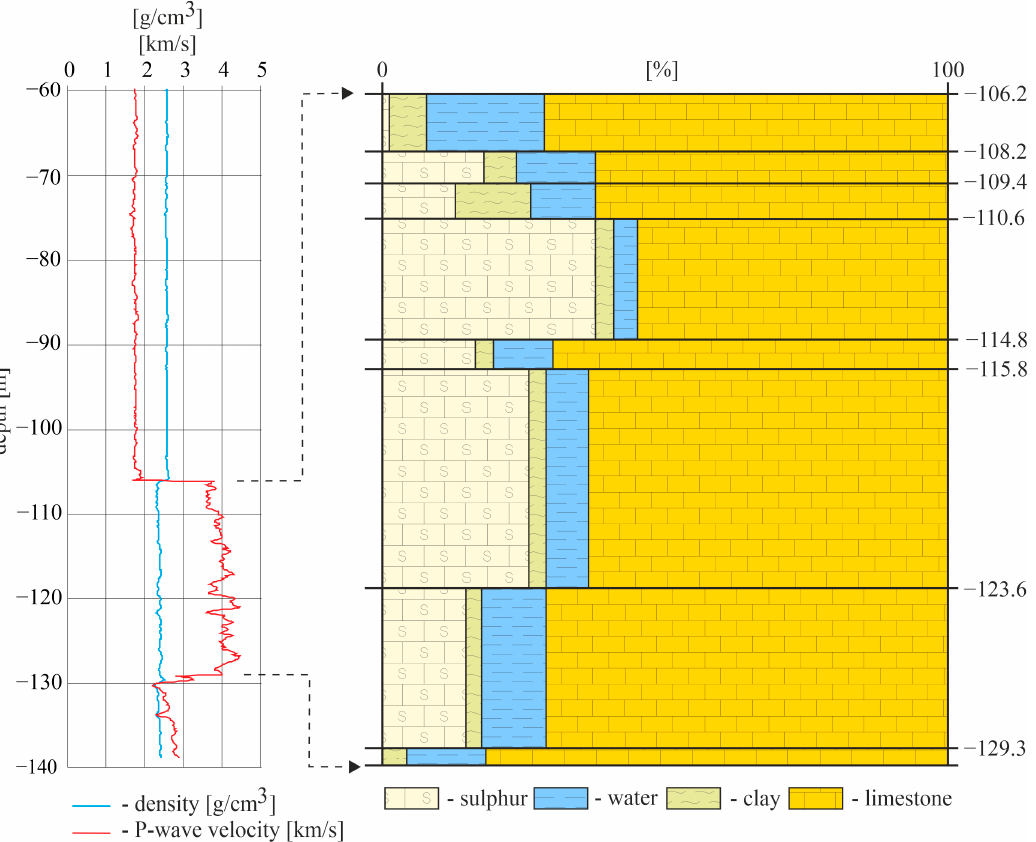
Figure 3. Wellbore O2. From the left: P-wave velocity ( red log ), bulk density ( blue log ) and lithology.